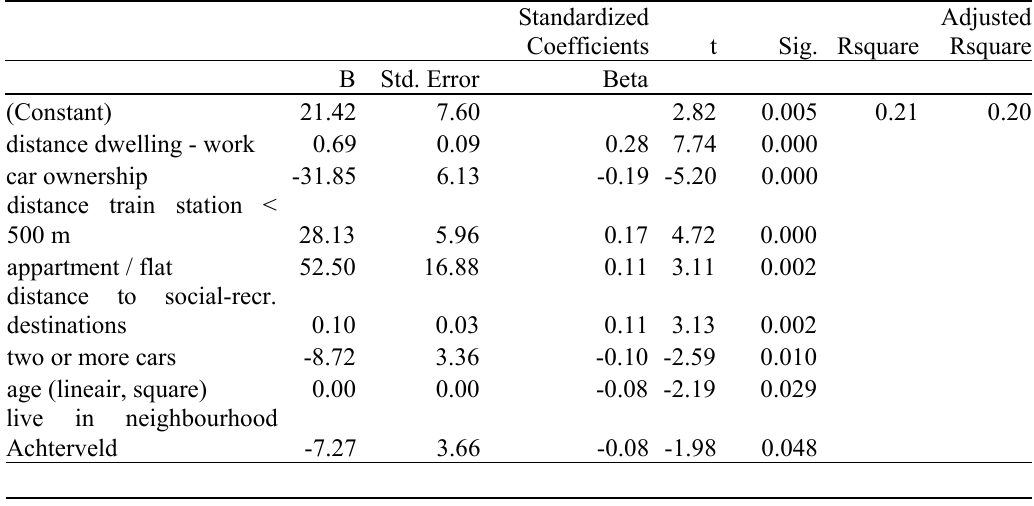
Table 4. Models for total distance travelled by public transport, without and with preference